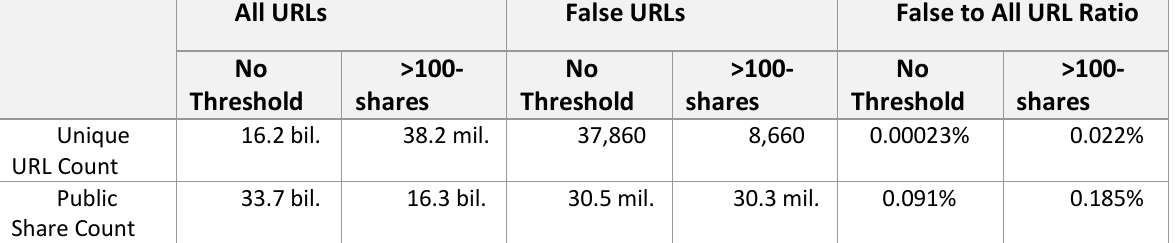
Table A1 . Results of Facebook’s internal analysis of how the number and composition of URLs in the URL dataset changes when a 100 public share threshold is applied. All URLs False URLs False to All URL